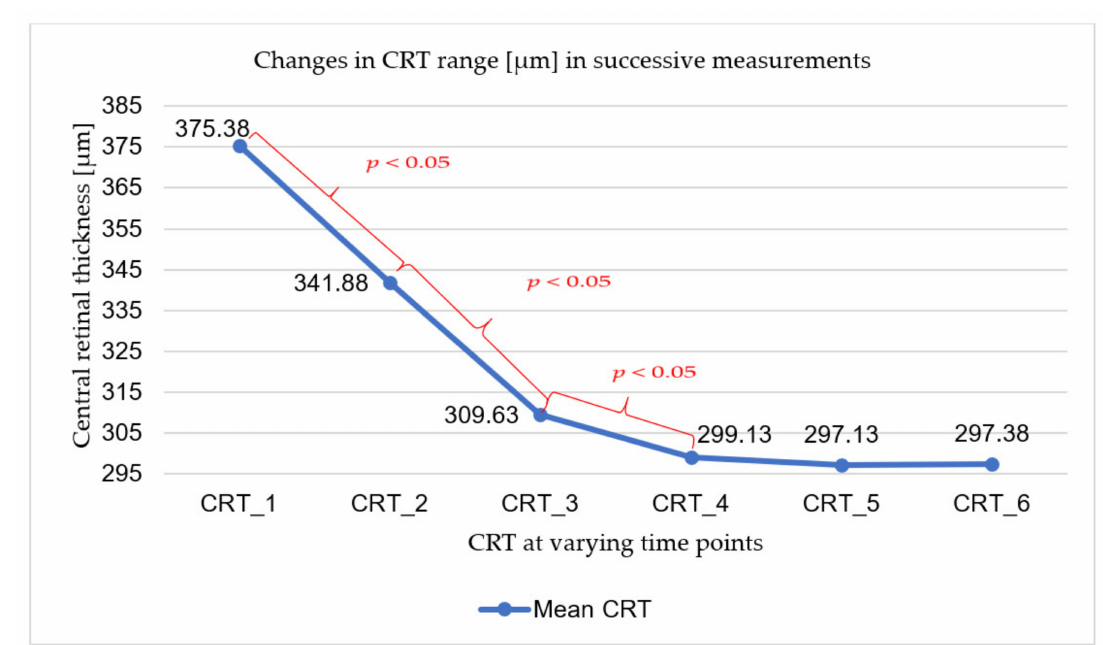
Figure 2. Changes in CRT range ( µ m) in successive measurements. Color indicates statistically significant differences between two consecutive measurements.